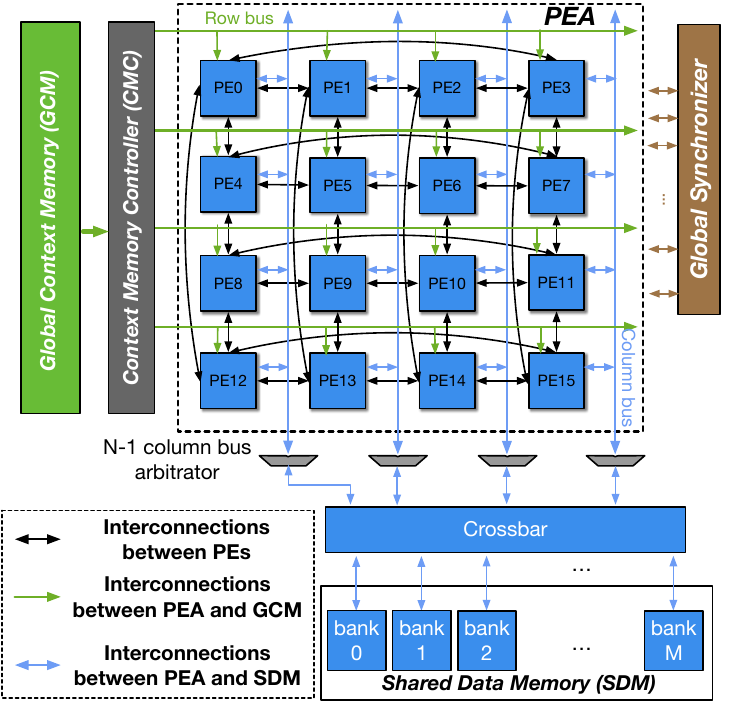
Figure 1. A 4 × 4 CGRA consists of processing element array (PEA), global context memory (GCM) and shared data memory